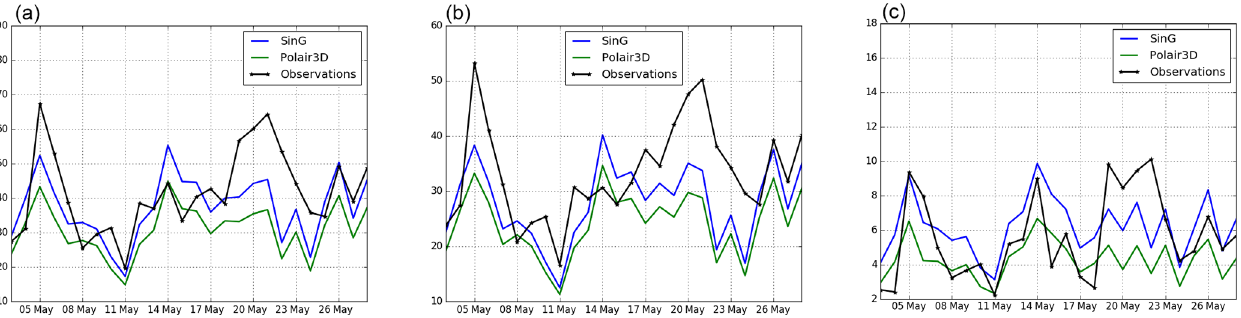
Figure 12. Daily average concentrations of NO x (a) , NO 2 (b) and NO (c) (µgm − 3 ) observed and simulated at PA04C station with SinG and Polair3D.